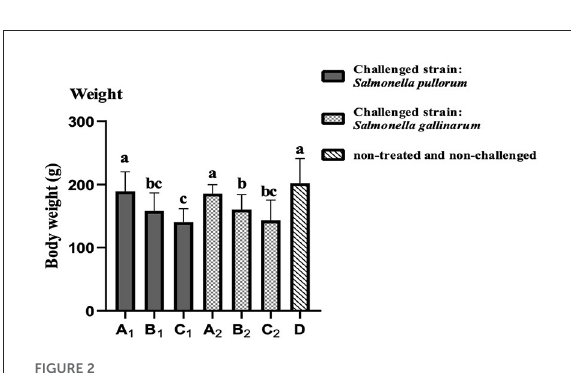
FIGURE2 The average BW of the birds of different